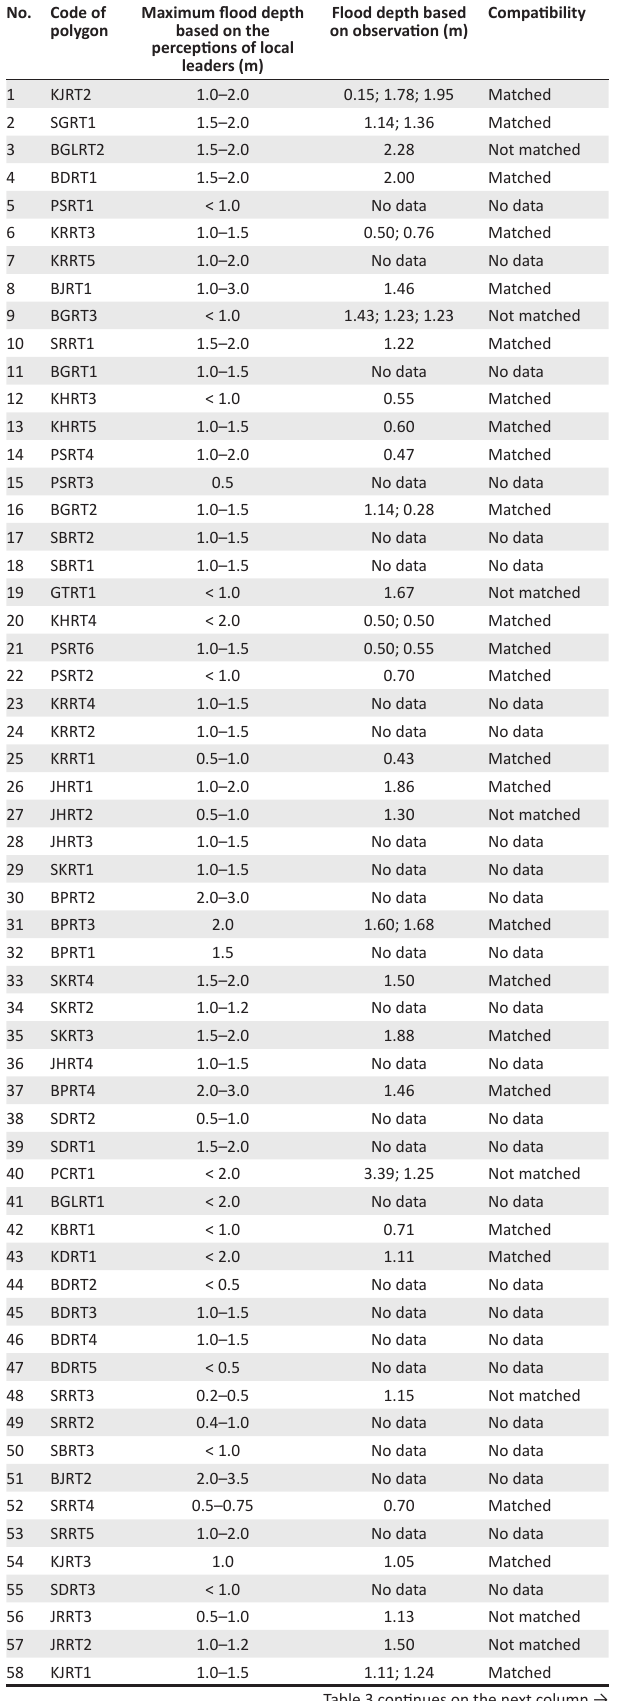
TABLE 3 ( Continues... ): Compatibility assessment of the information obtained from the respondents and the field